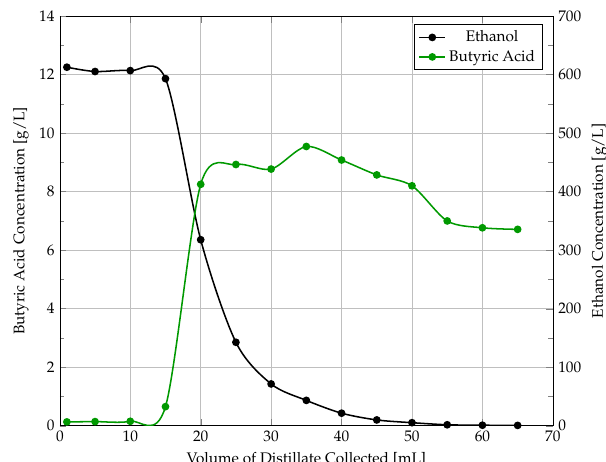
Figure 7. Distillate concentrations of ethanol and butyric acid during the lab-scale fractional distillation vs. the volume of distillate